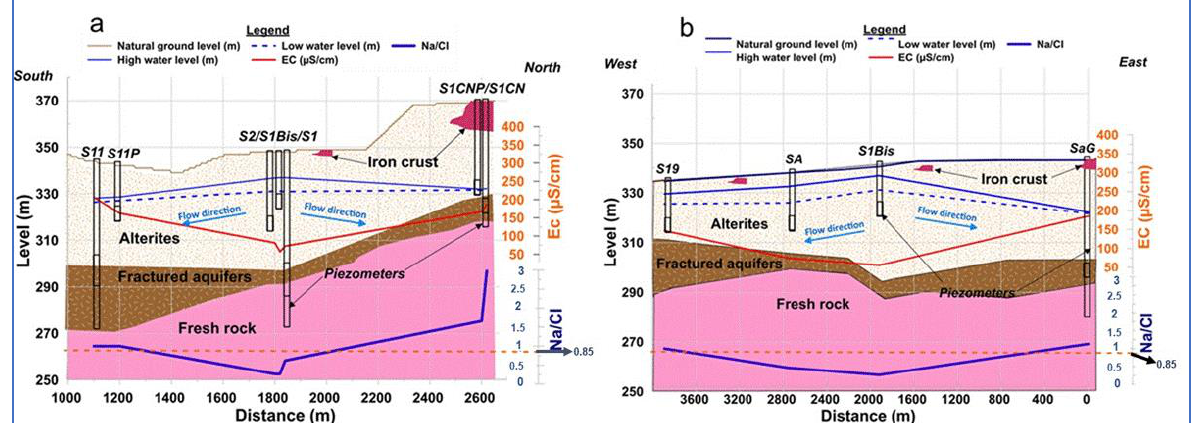
Figure 8. Spatial distribution of conductivity and Na/Cl ratios along the two transects: ( a ) north – south transect and ( b ) west – east transect.